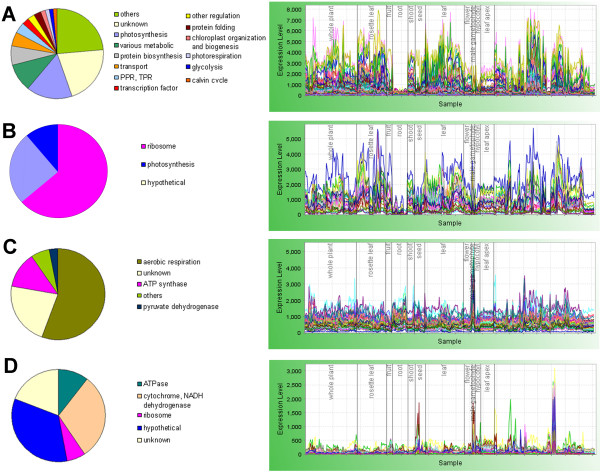
Regulons with organelle-specific functions and organelle-encoded genes. Regulon 2, photosynthesis (for clarity, representative expression profiles of 200 randomly chosen genes from this regulon are shown) (A); Regulon 49, plastid-encoded genes (B); Regulon 29, mitochondrial respiration (C); Regulon 34, mitochondrion-encoded genes (D). The plots on the right side show expression profiles of the genes in respective regulon (each gene depicted with different color) across the 424 samples in the dataset. The samples have been arranged according to plant tissue. Pie charts are based on manual annotations from published data. RNA profiles plotted using MetaOmGraph [24,124].